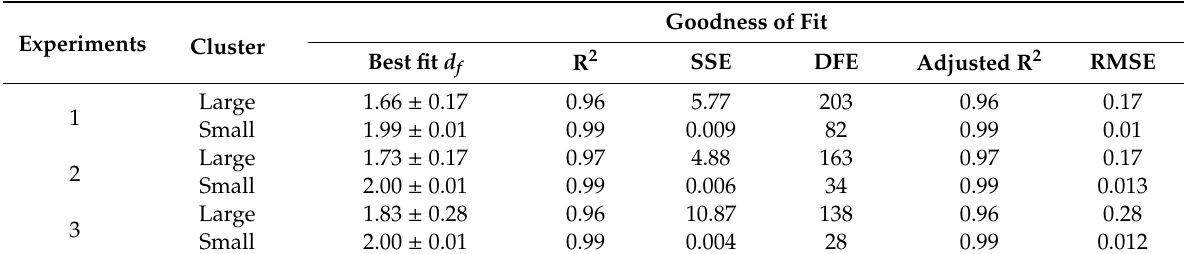
Figure 3. Log-log plots of average area A as a function of the radius of gyration R g for asphaltene aggregates formed under di ff erent precipitant concentrations. ( A – C ) represents aggregation induced by adding 52 vol%, 55 vol%, and 57 vol% heptane to model oil, respectively. The solid dark blue and black lines represent the best fit line for small clusters and large clusters, respectively. The solid red lines represent the prediction bounds for the fitted functions and the bounds reflect 95% confidence intervals. Single particles were excluded from the regression. Table 1. Estimation of fractal dimension by least square fitting for power law of R gd f